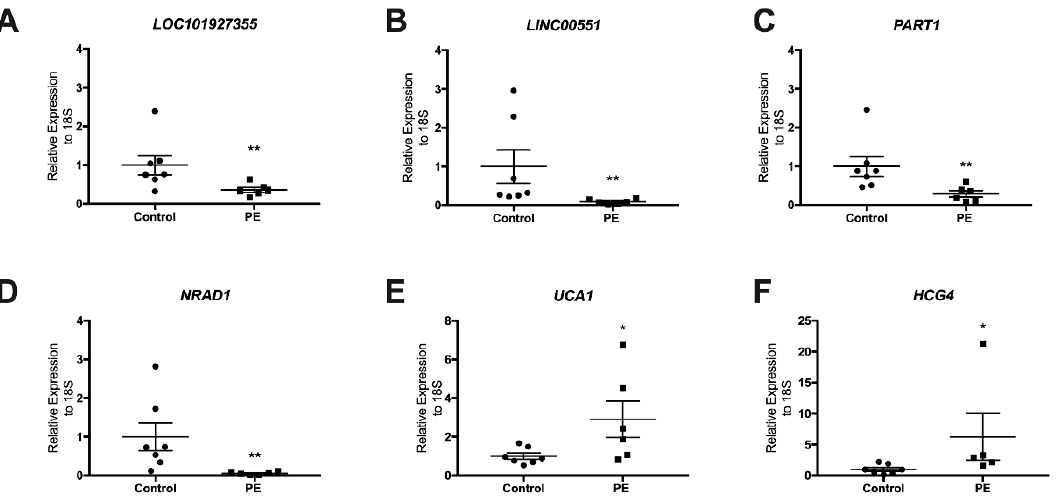
Figure 3 . LncRNAs’ expression in term placentas. LncRNAs ( A ) LOC101927355 , ( B ) LINC00551 , ( C ) PART1 , ( D ) NRAD1 , ( E ) UCA1 , and ( F ) HCG4 were validated in seven PE (squares) and seven control (circles) placentas; * p < 0.05, ** p < 0.01. Mann–Whitney test. The bars indicate the standard deviation.